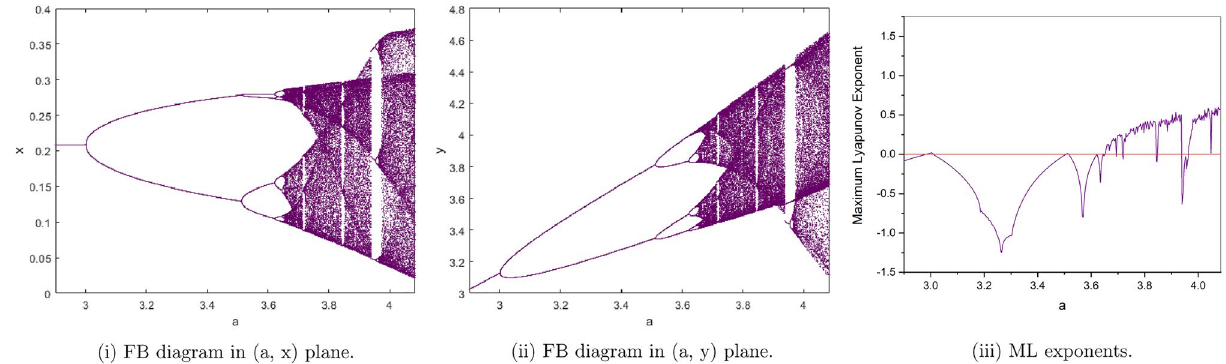
Figure 5. Bifurcation diagrams and ML exponents for the model (i) for values of b = 2.5, c = 0.2, e = 0.5, h = 1.022801547, a ϵ [2.9, 4.084].